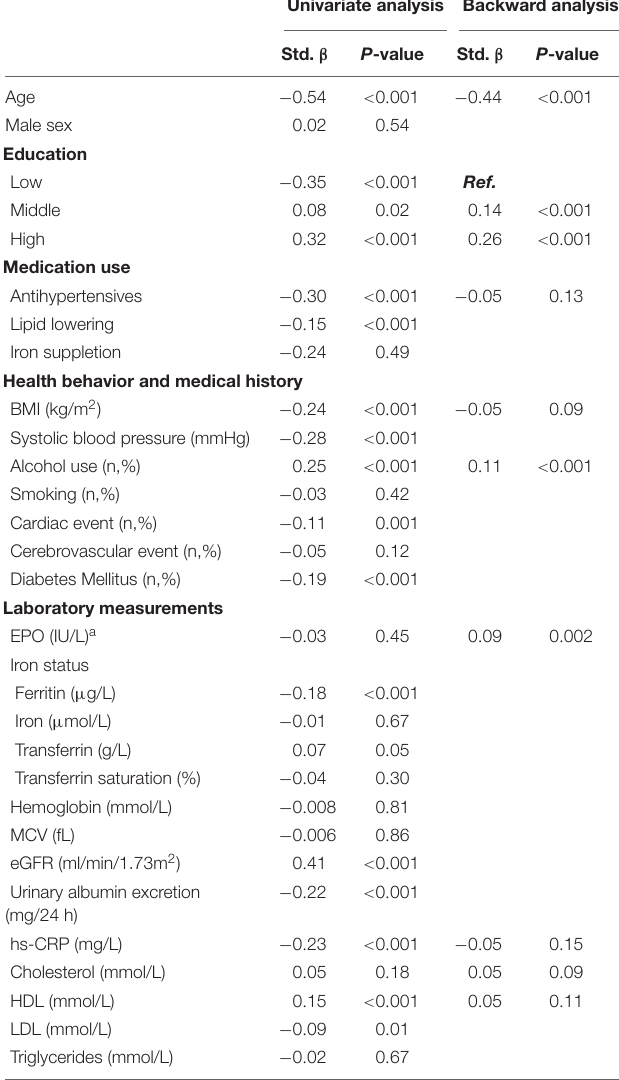
TABLE 3 | Univariate and backward linear regression analyses of potential determinants of RFFT scores. Univariate analysis Backward analysis Std. β P -value Std.